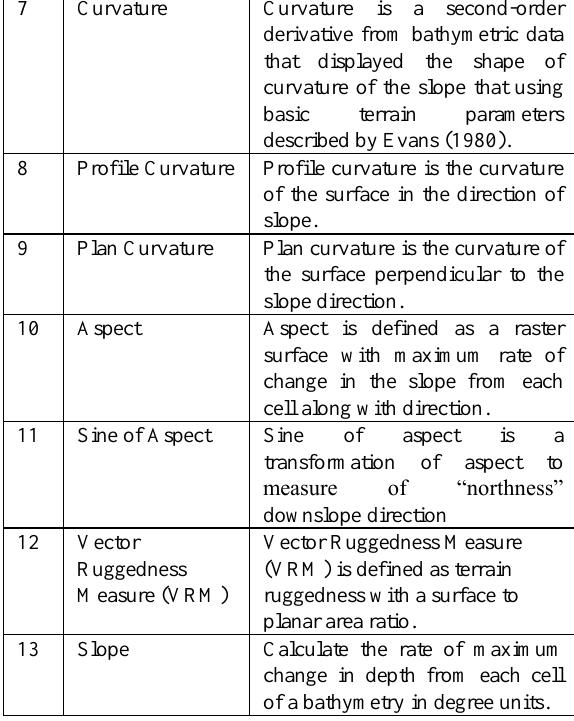
Table 3. The variables used in this study